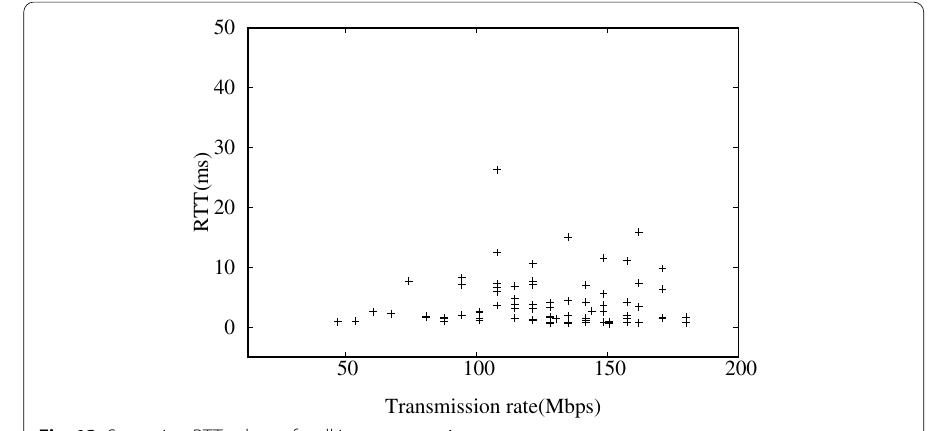
Fig. 13 Scattering RTT values of walking pattern w